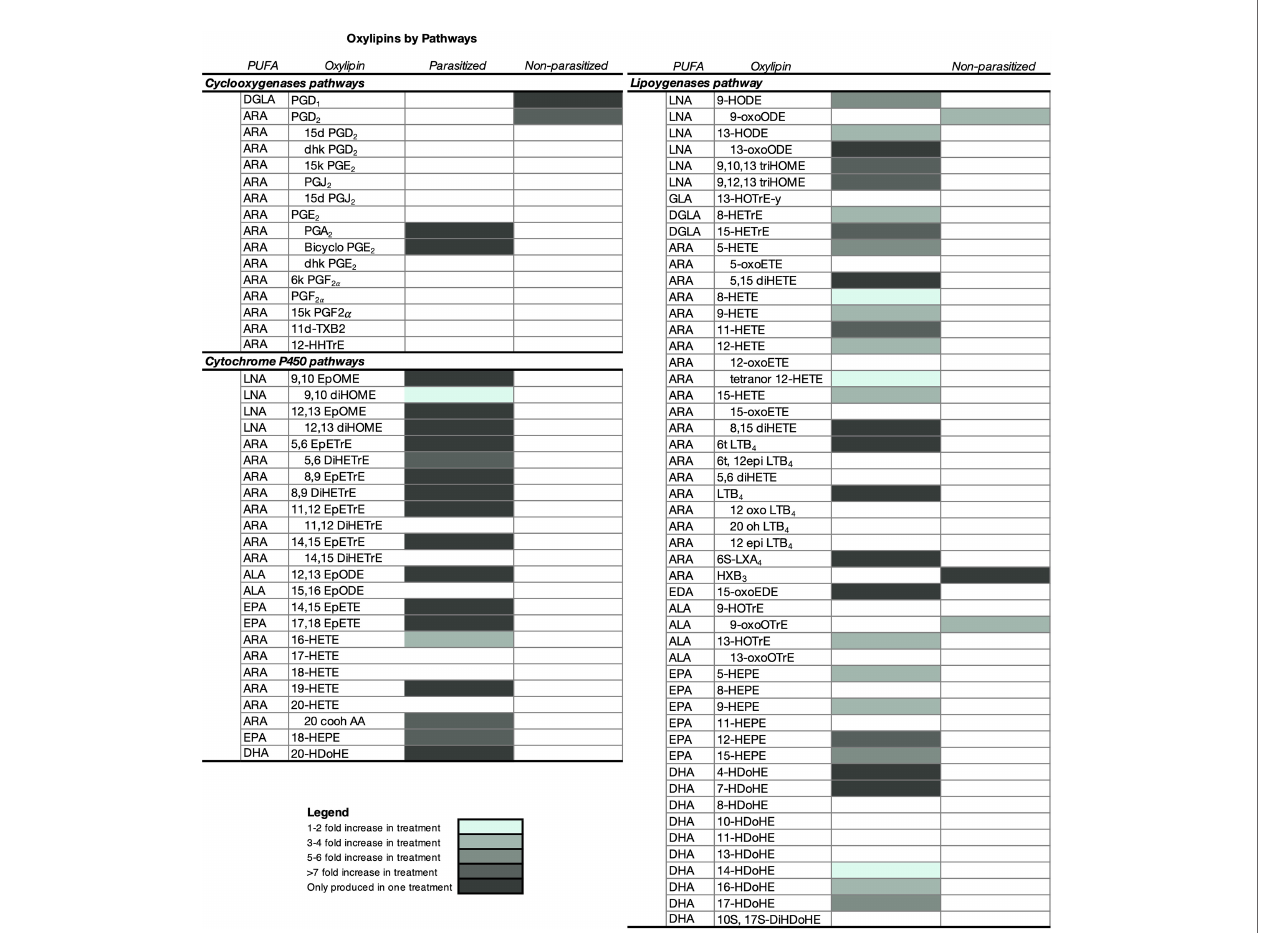
FIGURE 5 | Characterization of oxylipins and relative differences in the amount (mean ± SE) released by parasitized (infected) and non-parasitized (uninfected) fi eld Stagnicola elodes snails. Snails in the infected group were parasitized by Echinoparyphium sp. lineage 2. All samples were collected from two 250m 2 ditches along a road bisecting a wetland in Netley-Libau Marsh (50°C 18 ’ 48 ’’ N, 96°C 42 ’ 29 ’’ W). Oxylipins only detected in one group of snails are also shaded. ARA, arachidonic acid; DGLA, dihomo-g-linolenic acid; LNA, linoleic acid; ALA, a-linolenic acid; ADA, adrenic acid; EPA, eicosapentaenoic acid; DHA, docosahexaenoic acid; DPA, docosapentaenoic acid; GLA, g-linolenic acid; EDA, eicosadienoic acid; d, deoxy; dhk, dihydroketo; DiHDoPE, dihydroxy-docosapentaenoic acid; DiHETE, dihydroxy-eicosatetraenoic acid; DiHETrE, dihydroxy-eicosatrienoic acid; DiHOME, dihydroxy-octadecenoic acid; EpDoPE, epoxy-docosapentaenoic acid; EpODE, epoxy-octadecadienoic acid; EpOME, epoxy-octadecenoic acid; HEPE, hydroxy-eicosapentaenoic acid; HETrE, hydroxy-eicosatrienoic acid; HHTrE, hydroxyheptadecatrienoic acid; HOTrE, hydroxy- octadecatrienoic acid; HX, hepoxilin; LT, leukotriene; t, trans; and Tx,